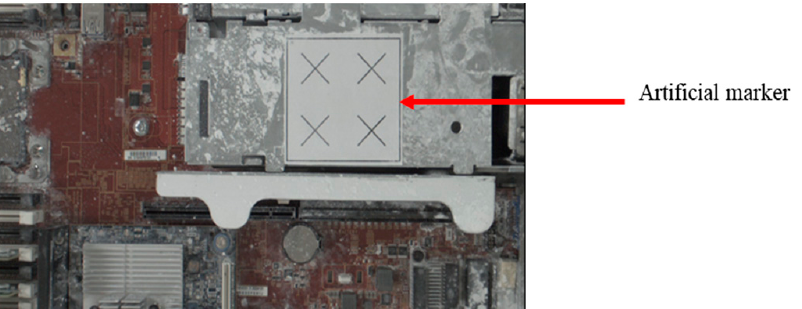
Figure 12. Sample image of the positioning marker w.r.t. the robot pose shown in Figure 11.